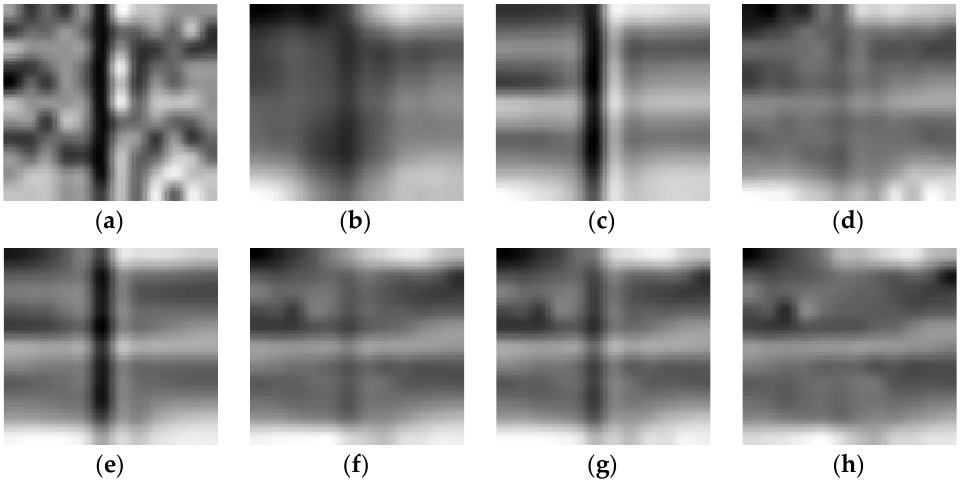
 Figure 14. Restored results in Urban image: ( a ) Original band 186; ( b ) KSVD; ( c ) BM3D; ( d ) Figure 15. 4 magnified results of the various approaches in the red rectangle of Figure 14: ( a ) ANLM3D; ( e ) BM4D; ( f ) LRMR; ( g ) DDL3+FT; ( h ) Our method. Original band 186; ( b ) KSVD; ( c ) BM3D; ( d ) ANLM3D; ( e ) BM4D; ( f ) LRMR; ( g ) DDL3+FT; ( h ) Our method.